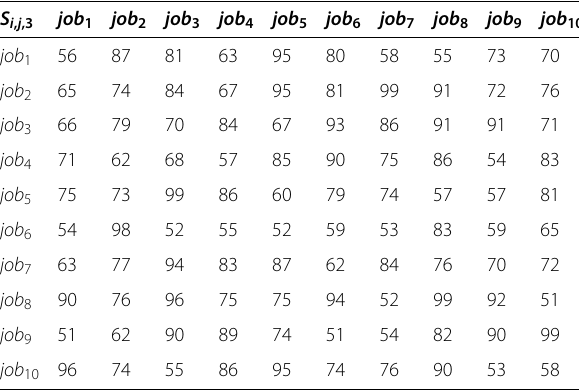
Table 5 Example of sequence-dependent setup times on machine 3